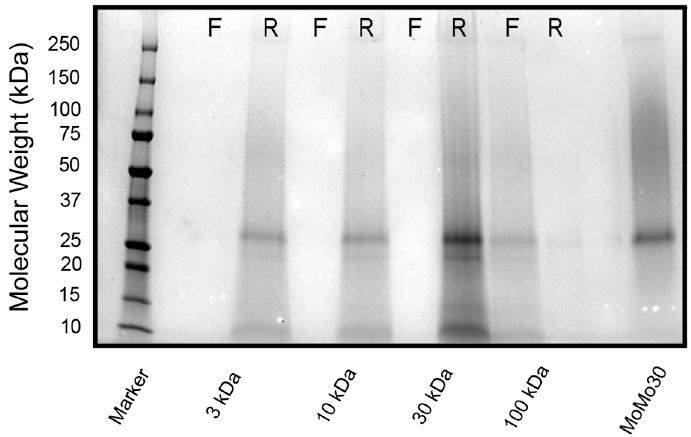
Figure 6. M. balsamina leaf extract was run on an SDS-PAGE gel after passing through a series of molecular weight cutoff filters. “R” represents the liquid retained by the filter, and “F” represents the filtrate from the filter. The gel was stained in C.B.B. to elucidate any possible proteins in the extract.